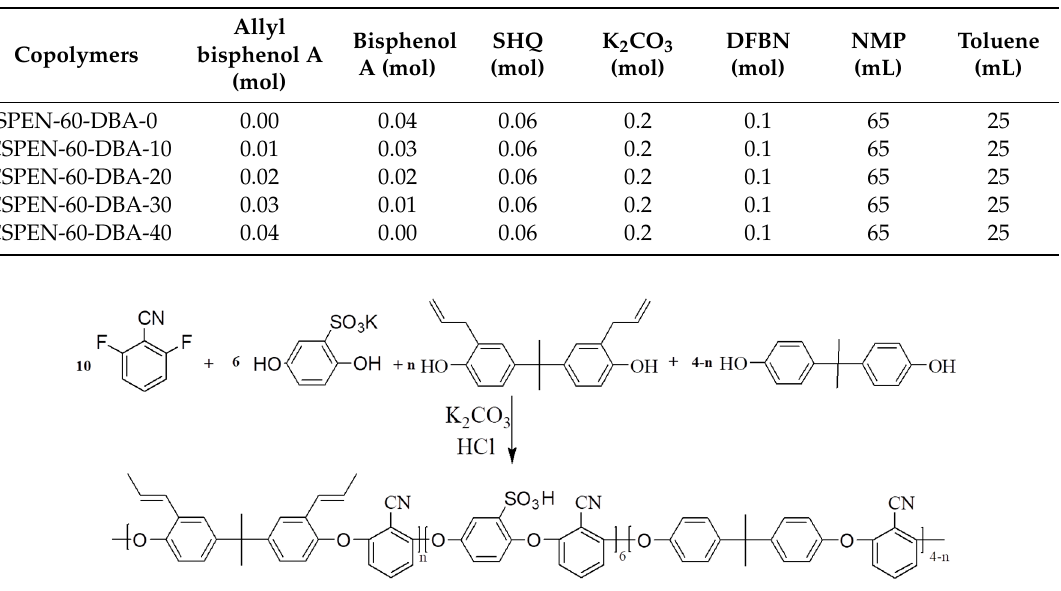
Table 1. Raw material ratio for the synthesis of side chain crosslinkable sulfonated poly(aryl ether nitrile) containing allyl bisphenol A with di ff erent molar fractions.